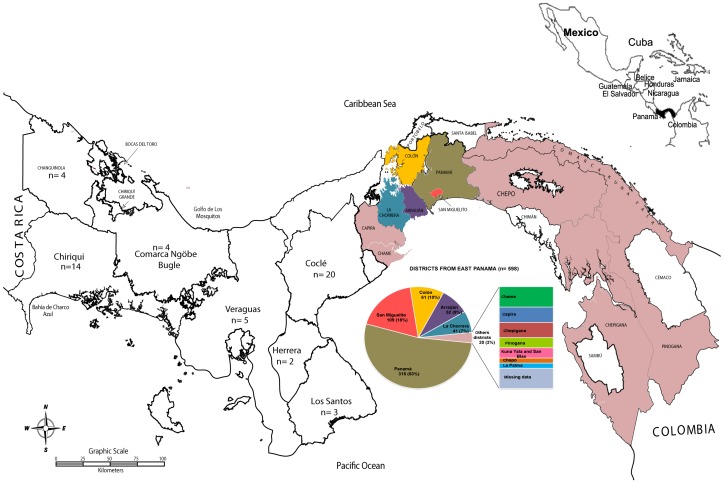
Geographic distribution of Panamanian subjects living with HIV participating in the study.Map of Panama indicating the number of infected subjects located in each of the nine provinces (Bocas del Toro, Chiriquí, Veraguas, Herrera, Los Santos, Coclé, Colón, Panamá and Darién) and native territories of Comarcas Ngöbe Buglé, Kuna Yala and Emberá Wouman. The pie chart that represents the proportion of subjects located at the different districts from eastern Panama which includes the provinces of Panama, Colón, Darién and Comarca Kuna Yala.